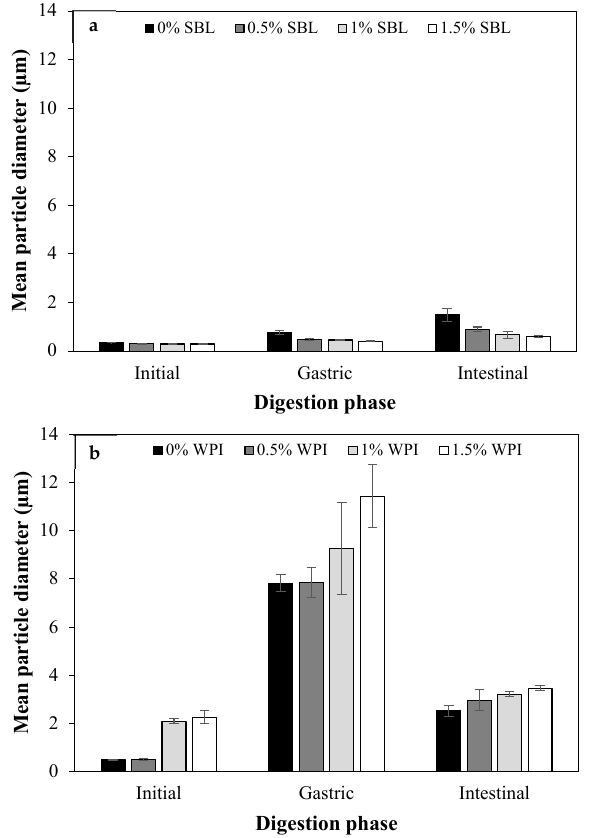
Figure 4. Particle size ( µ m) of curcumin-loaded nanoemulsions stabilized with ( a ) soybean lecithin (SBL) or ( b ) whey protein isolate (WPI) and different sodium alginate concentrations (0, 0.5, 1 and 1.5%) at different phases of in vitro